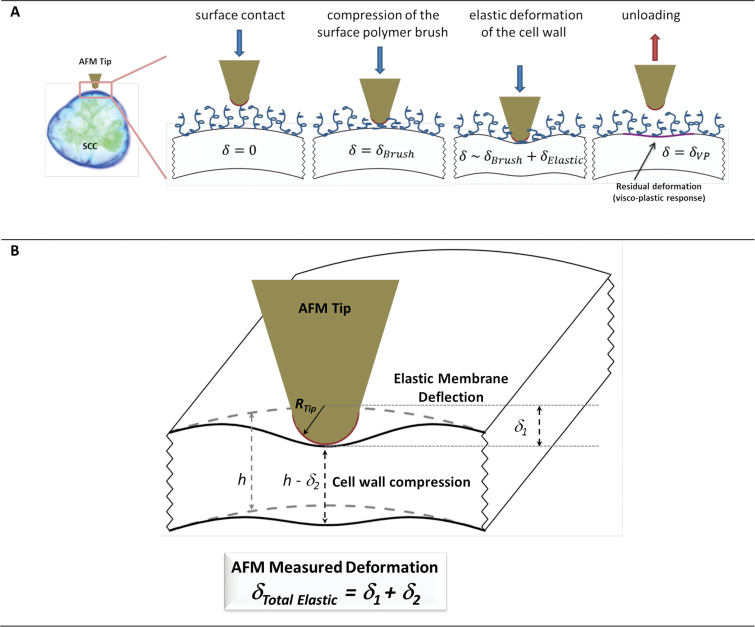
(A) A schematic representation of a postulated deformation sequence during the indentation of an SCC using a blunt AFM tip. (B) A physical model of plant cell wall deformation during the nanoindentation with an AFM tip. The AFM spring (with a constant, k
AFMcantilever) is balanced by the elastic response from cell deformations that depend on the material properties of the wall; the elastic membrane spring constant (k
M) and effective modulus of the wall (E˜wall). The latter is a function of the Young’s elastic modulus (E) and the Poisson ratio (v). (This figure is available in colour at JXB online.)